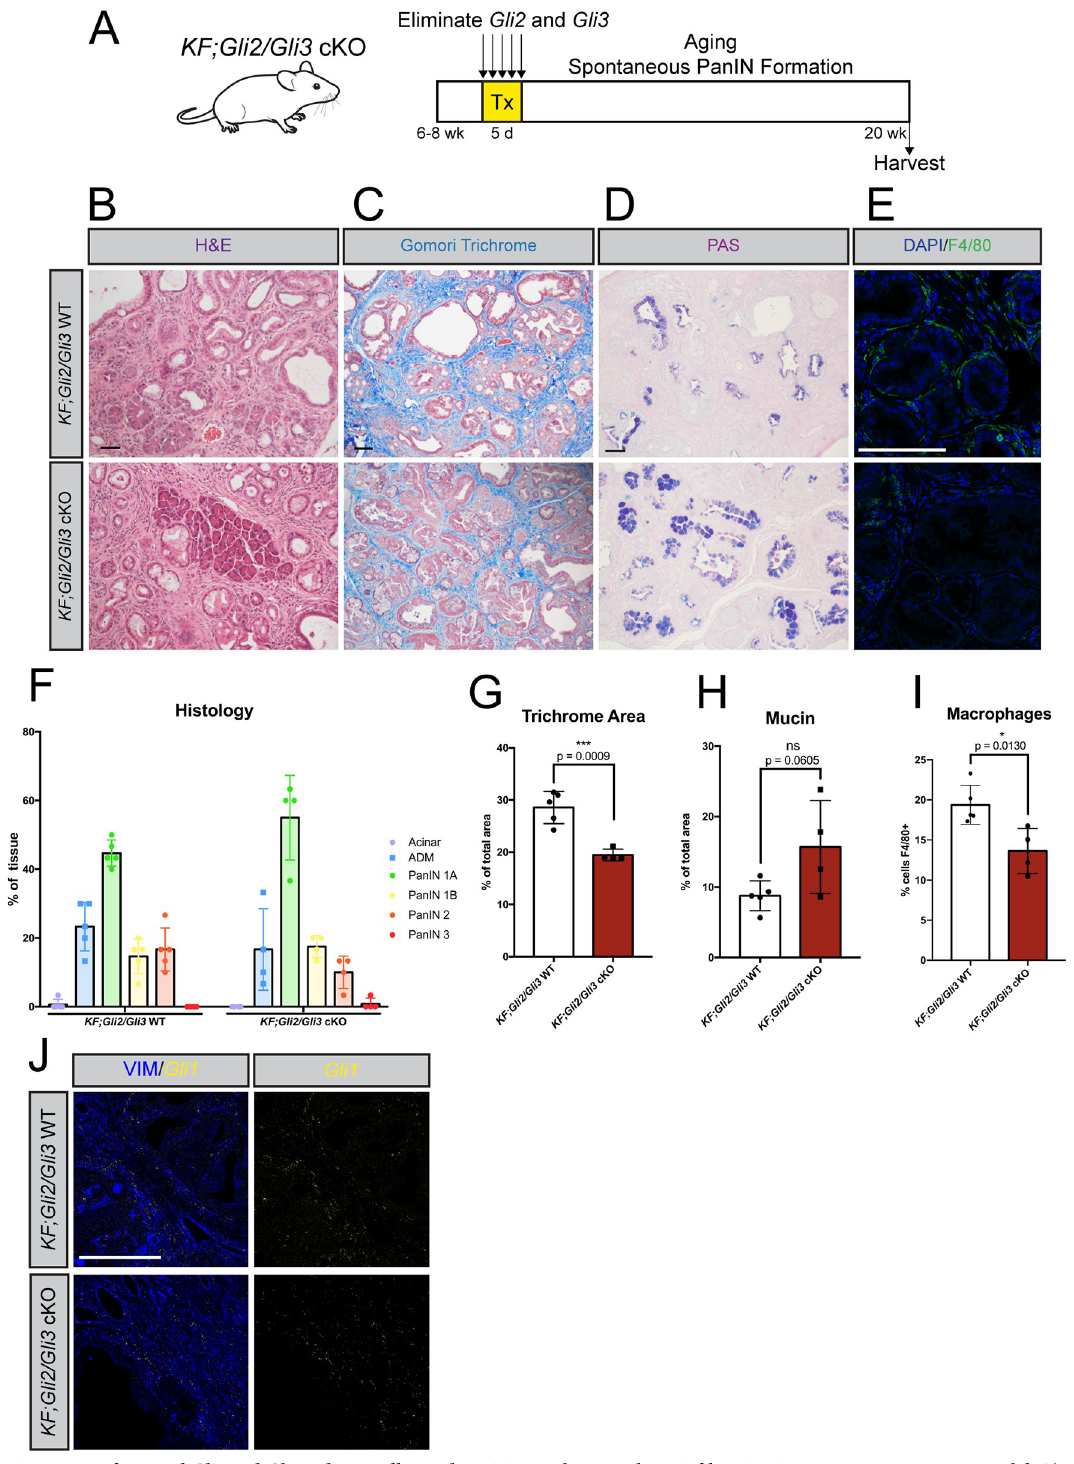
Fig 3. Loss of stromal Gli2 and Gli3 reduces collagen deposition and macrophage infiltration in a spontaneous PanIN model. A ) Cartoon depicting experimental strategy. Adult KF;Gli2/Gli3 cKO mice were given tamoxifen (Tx, 200 mg/kg) once a day for 5 days. Pancreata were harvested at 20 weeks of age. B-D ) Histological analysis of KF;Gli2/Gli3 cKO; LSL-tdTomato/+ (bottom) pancreata compared to KF;Gli2/Gli3 WT; LSL-tdTomato/+ tissue (top), including H&E ( B ), Gomori Trichrome ( C ), and PAS ( D ) staining. E ) Immunofluorescent antibody detection of macrophages (F4/80, green). DAPI staining in blue. F ) Pathology analysis of PanIN